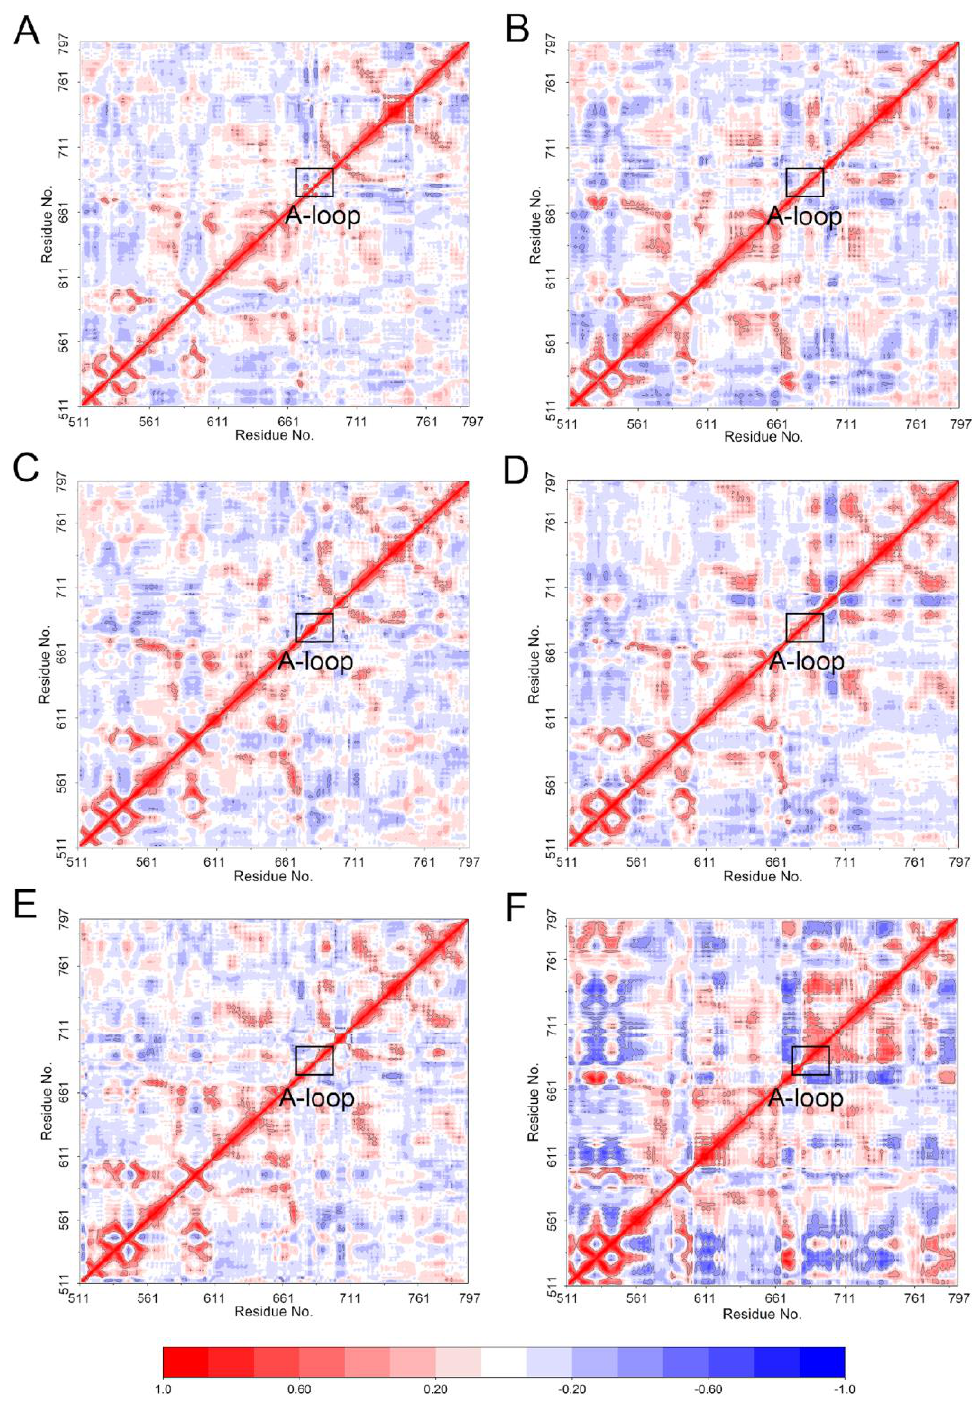
Figure 3. Dynamical cross-correlation (DCC) analysis of fluctuations of residues from classical MD simulations. ( A ) Mps1 WT /reversine; ( B ) Mps1 C604Y /reversine; ( C ) Mps1 WT /Cpd-5; ( D ) Mps1 C604Y